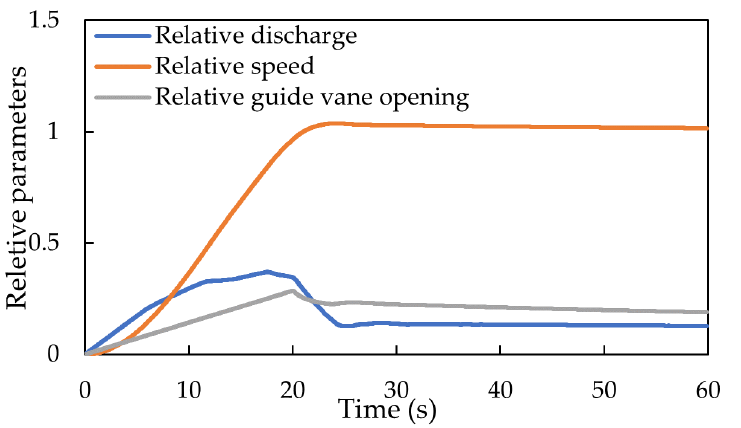
Figure 2. Regulation of the guide vane opening during turbine start-up and discharge and rotating speed